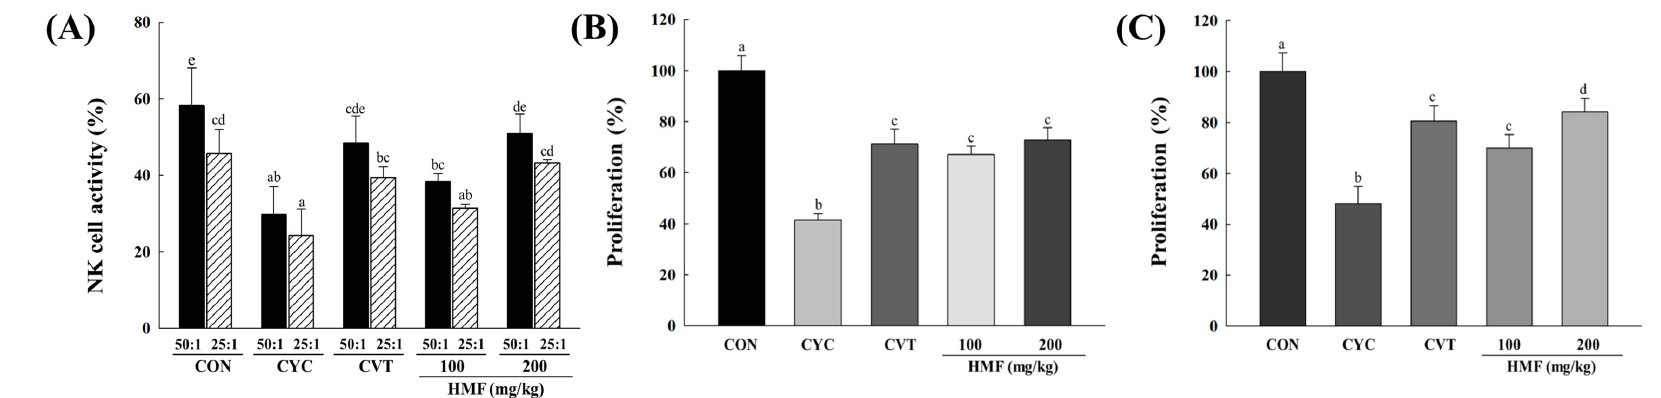
Figure 2. Effects of HMF on natural killer (NK) cell activity and splenic lymphocyte proliferation in CYC-induced mice. HMF (100 mg/kg or 200 mg/kg) or CVT (200 mg/kg) was administered orally once daily for 28 days to CYC-induced mice. ( A ) NK cell activity was determined by lactate dehydrogenase (LDH) assay as described in Materials and Methods. The E:T ratio indicates ratio of effector cells (splenocytes) and target cells (YAC-1 cells); ( B ) Concanavalin A (Con A)-induced T-lymphocyte proliferation; ( C ) LPS-induced B-lymphocyte proliferation. Cell proliferation was measured by using CCK-8 kit. Values with the different letters are significantly different ( p < 0.05). CYC, cyclophosphamide; CVT, immunostimulatory polysaccharide-rich extract of the root of North American ginseng ( Panax quinquefolius ); HMF, high-molecular-weight fraction of Cynanchum wilfordii